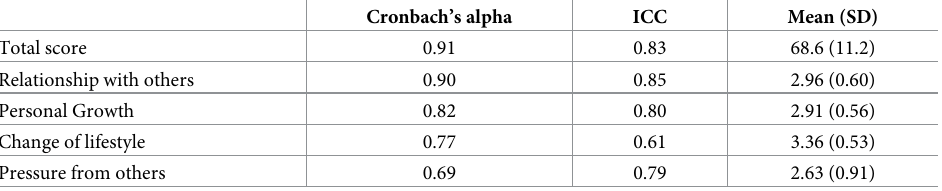
Table 4. Cronbach’s alpha (N = 136), intraclass correlations between test and retest (n =